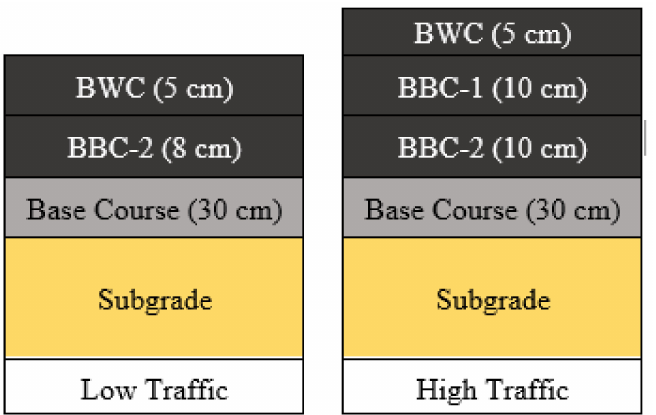
Figure 8. Typical pavement cross section used in the study for high and low